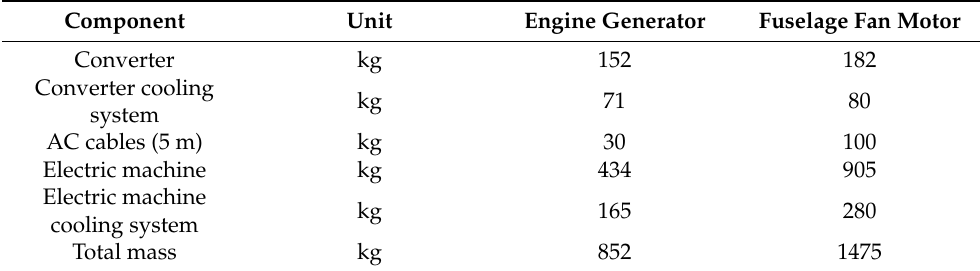
Table 10. Component mass breakdown for the turbo-electric power train (Sources: [82,83]). Component Unit Engine Generator Fuselage Fan Motor Converter kg 152 182 Converter cooling kg 71 80 system